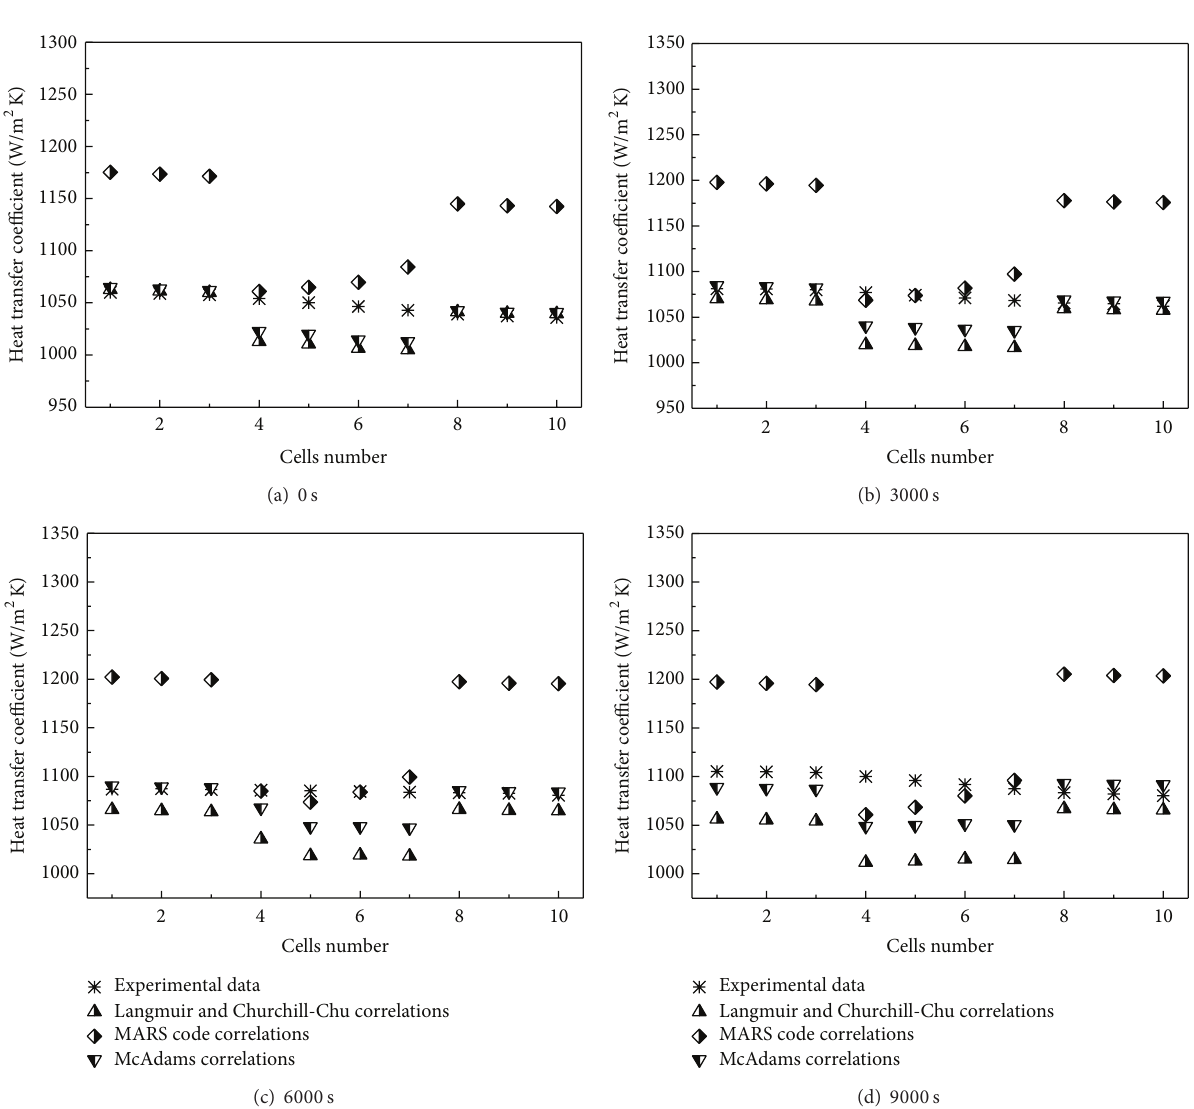
Figure 7: Comparison of tube outside heat transfer coefficients with natural convection correlations in different cells along the heating tube at different